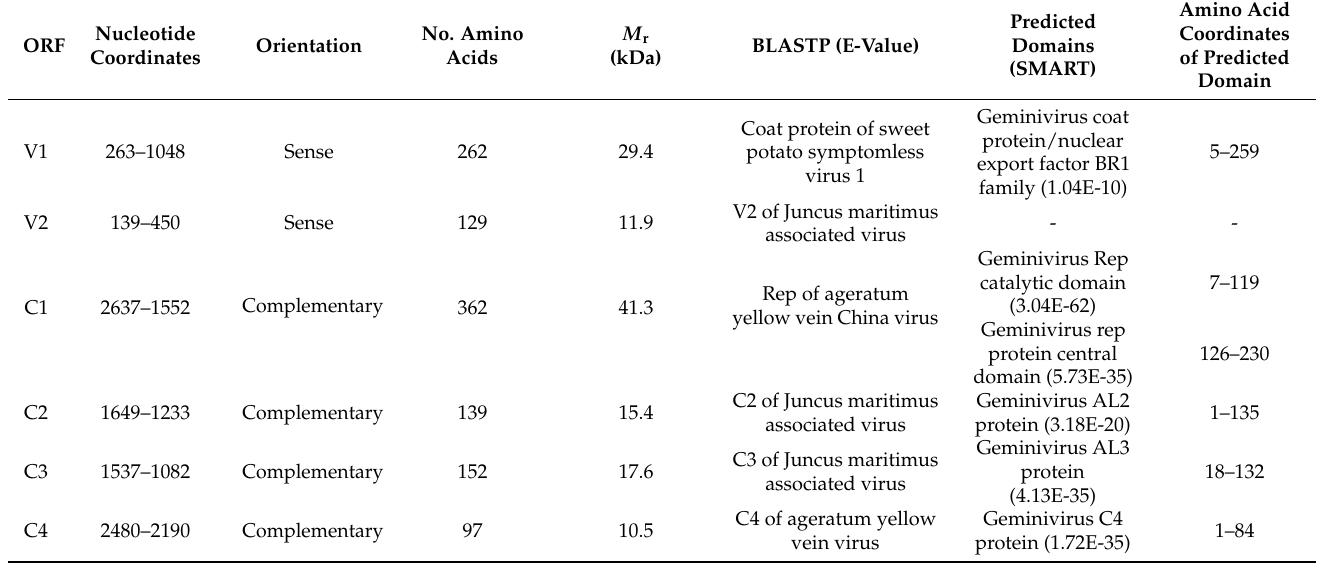
Table 1. ORFs and encoded proteins in the genome of soybean yellow leaf curl